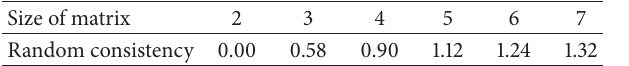
Table 1: Average random